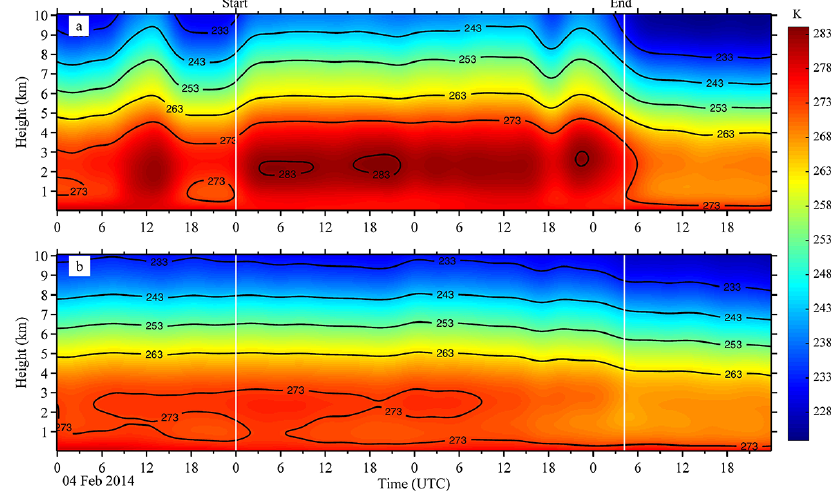
Figure 6. Comparison of temperature retrievals between zenith (a) and off-zenith (b) observation in heavy-snowfall conditions. The start and end times of snowfall are indicated by the vertical lines. The time series starts at 00:00UTC on 4 February